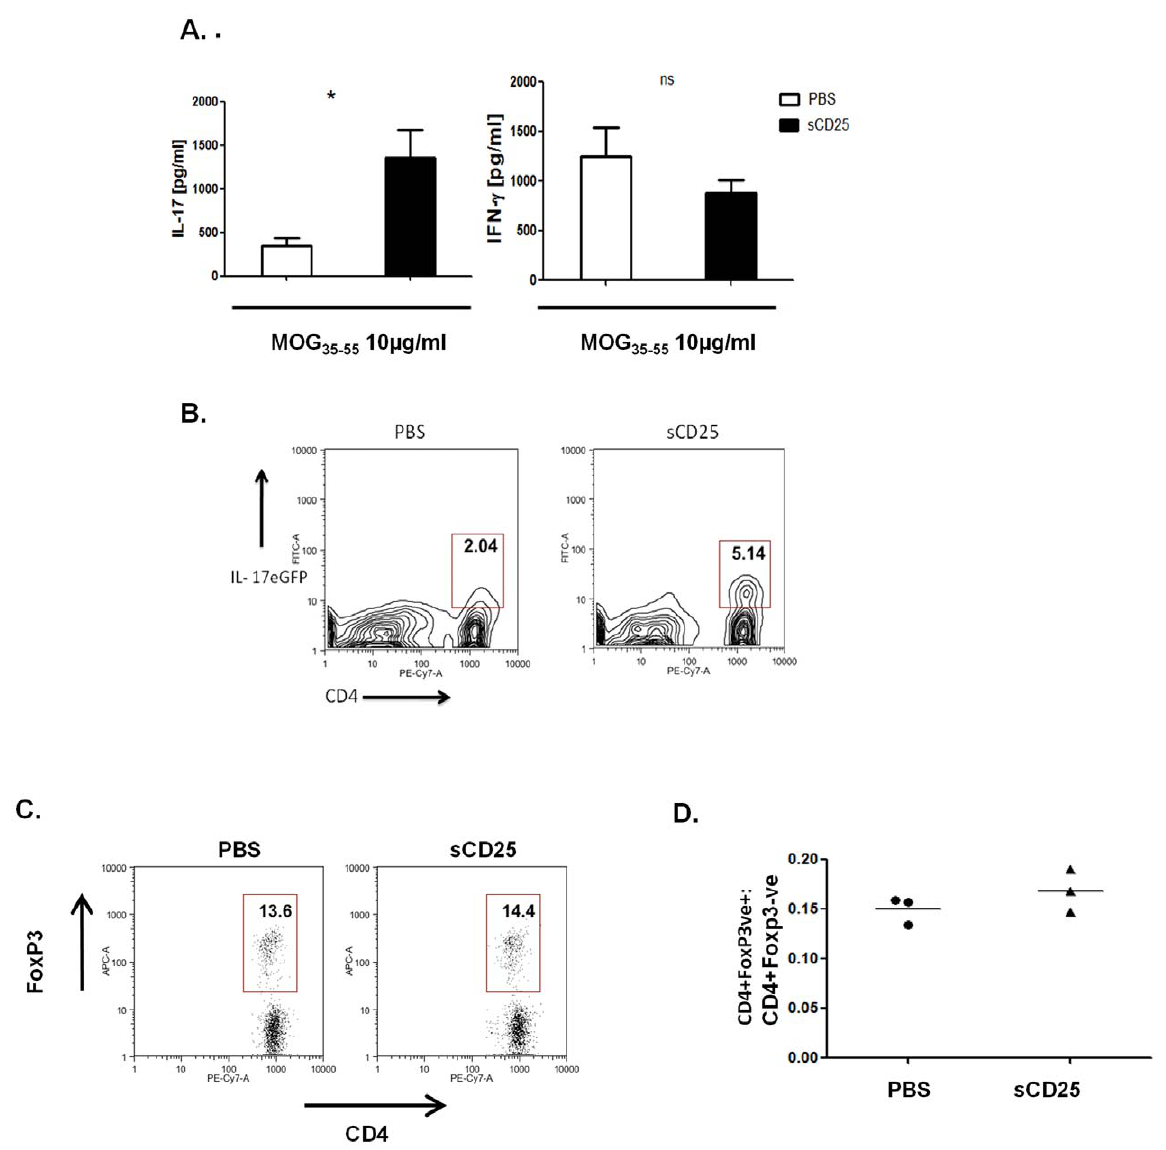
Figure 2. sCD25 enhances peripheral antigen specific Th17 responses. ( A ) Levels of IL-17A and IFN c secreted by draining lymph node cells of mice immunized and treated as above (3 per group), isolated after 9 days, and restimulated ex vivo with MOG 33 2 55 (10 m g/ml) for 72 hours. ( B ) Percentage of CD4 + IL-17A-eGFP + ve cells after treatment as above and ex vivo restimulation for 72 hours. ( C ) Percentage and ( D ) relative number ratios of CD4 + FoxP3 + :CD4 + FoxP3- T cells in the draining lymph nodes of both sCD25 and control treated immunized mice. 3 mice per group were analysed. Data in D & G is representative of mean + / 2 standard deviation. Statistical Significance determined by unpaired student’s t-test, * p # 0.05, **p #